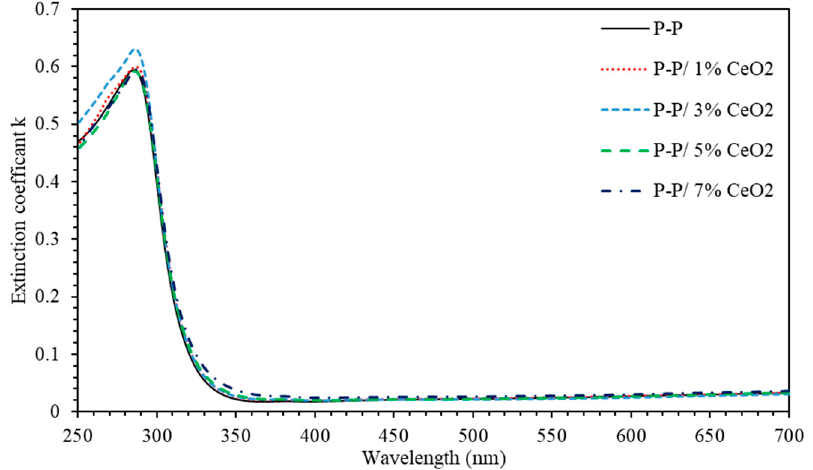
Figure 3. Extinction coefficient k of (PMMA-PS)/CeO 2 nanocomposite thin films with various CeO 2 NPs concentrations.